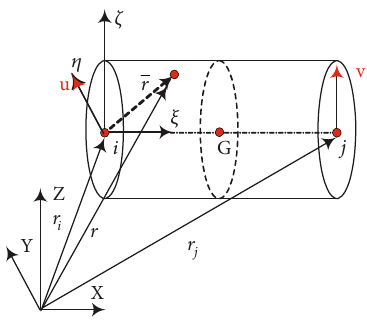
Figure 6: Rigid body described by